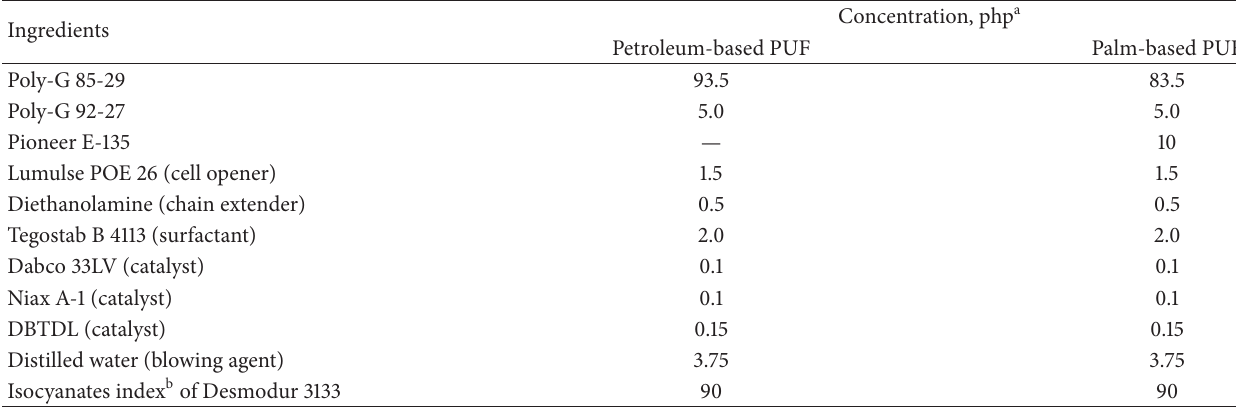
Table 2: Formulation of petroleum- and palm-based PU foams.